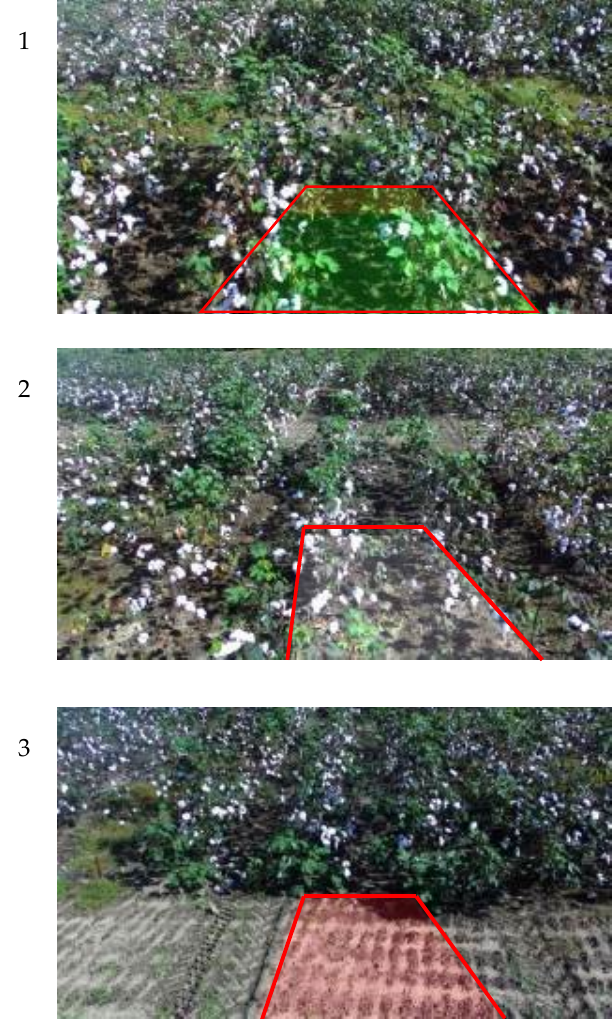
Figure 6. Ranking the detection of the rows (the upper image means detection is successful as it shows green and yellow stripes, center image detection with gray stripe is moderately successful, and the bottom with red stripe means no rows are detected).